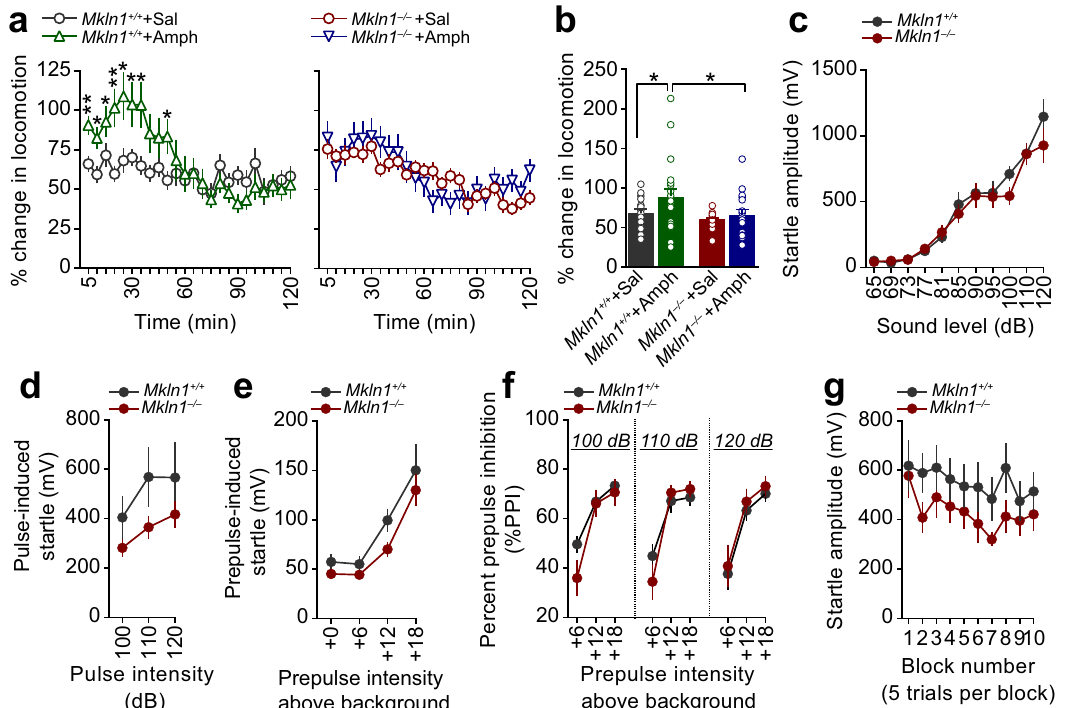
Fig. 2 Mkln1-null mice exhibit intact sensorimotor gating function but decreased locomotor sensitivity to amphetamine. a Locomotor response to acute amphetamine (2.5 mg/kg) challenge after considering differences in baseline locomotion. Compared with the respective saline-treated groups, amphetamine signi fi cantly increased locomotor activity in Mkln1 + / + mice (left panel) but had negligible effect in Mkln1 – / – mice (right panel; genotype× drug × time bins: ( F (23,1518) = 2.23, P < 0.01). Restricted analyses to each genotype groups revealed a pronounced drug effect in Mkln1 + /